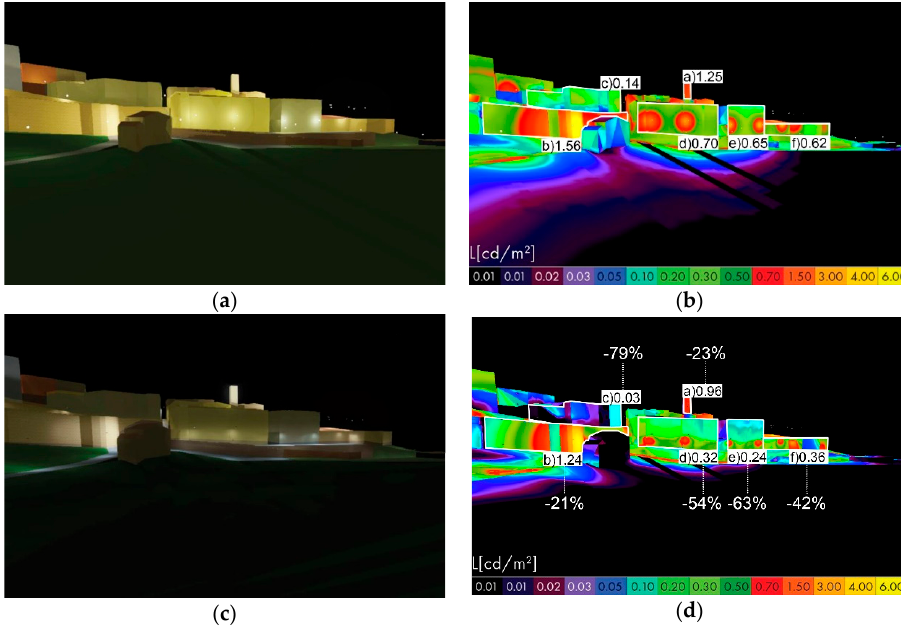
Figure 10. Observation point E1 (simulation performed using Dialux EVO software): ( a ) render of the ex-ante condition; ( b ) false colour render of the ex-ante luminance distribution. In evidence the analysed vertical surfaces and the corresponding average luminance values; ( c ) render of the ex-post condition; ( d ) false colour render of the ex-post luminance distribution. In evidence the analysed vertical surfaces, the corresponding average luminance values and the Relative Differences (RD) between the average luminance of the ex-ante and the ex-post installations.